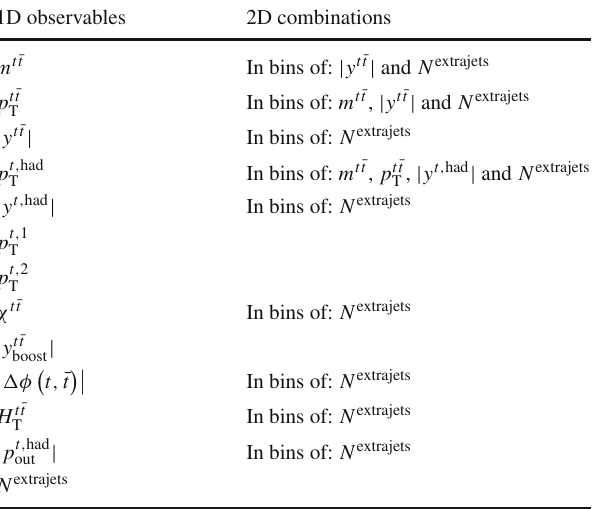
Table 5 The single- and double-differential spectra, measured in the resolved topology at particle level 1D observables 2D combinations